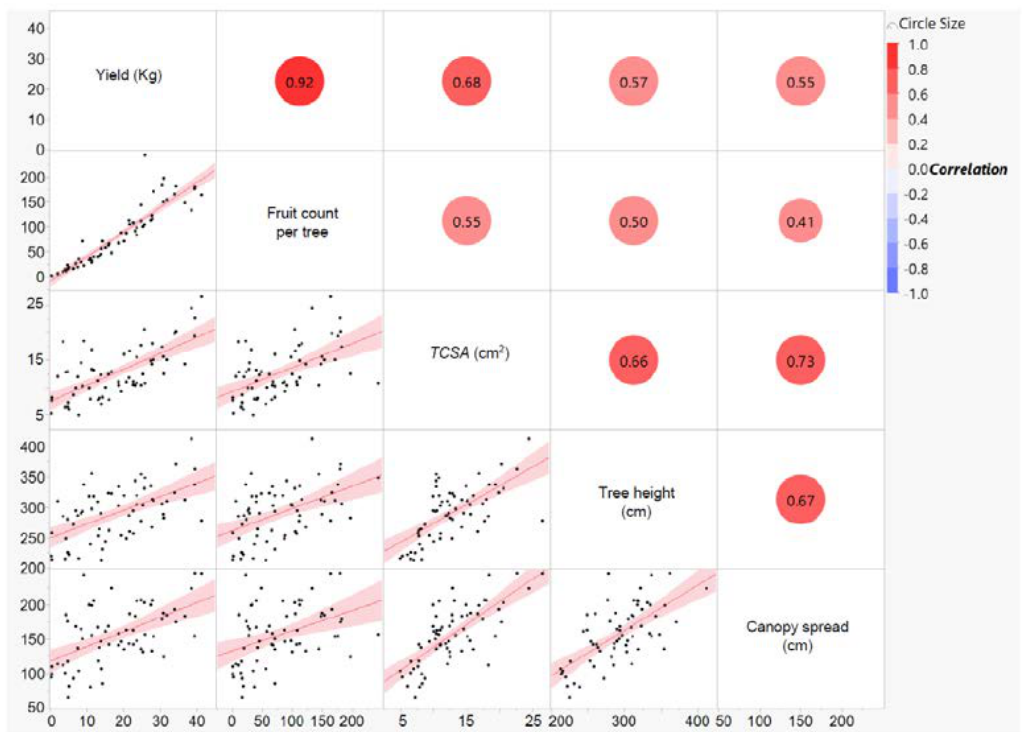
Figure 8. Correlations amongst yield, fruit counts per tree, trunk cross-section area ( TCSA ), tree height, and canopy spread of Honeycrisp on eight rootstocks in the fall of 2017. Linear regression is shown as the red line; the shadowed area indicates 95% confidence; regression graphs and values of correlation coefficient r are shown for each pair of parameters where they cross.